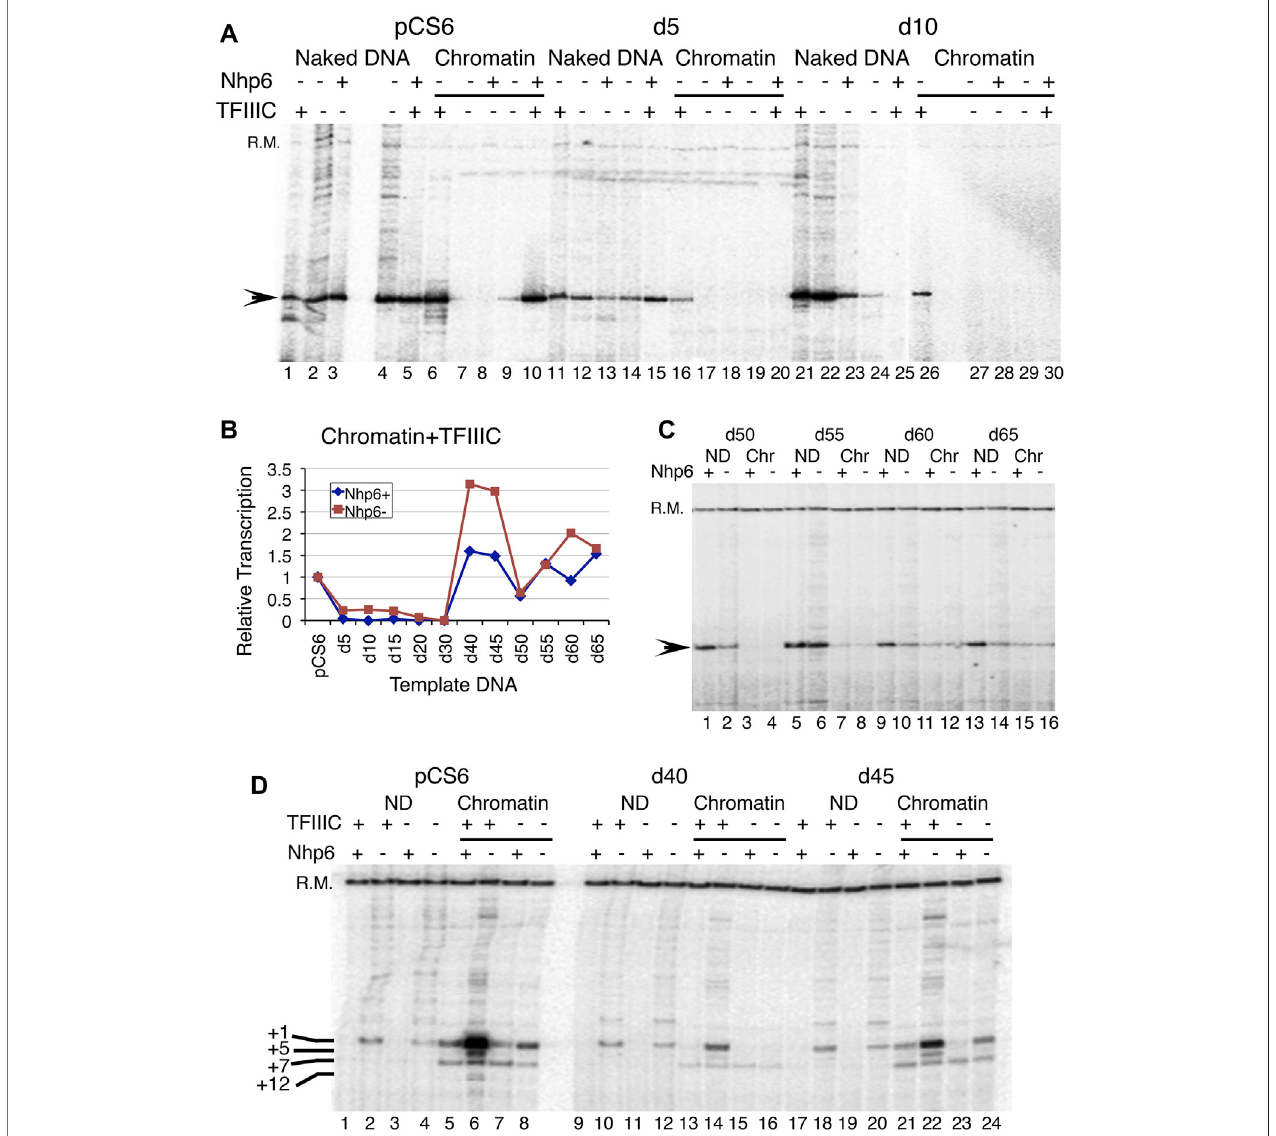
FIGURE3| Effect ofNhp6on transcription ofdeletion clones. (A) Effect ofa180-ngNhp6 addition onthetranscriptionofnakedand chromatinizedpCS6,d5, and d10 plasmids in vitro . Nhp6 supports the TFIIIC-dependent transcription of pCS6 but not of d5 and d10. (B) Quanti fi cation results of Nhp6 effect on the chromatin transcriptions of pCS6 and all deletion clones in the presence of TFIIIC with (180 ng) and without Nhp6 are plotted. Measured transcript levels were obtained by fi rst normalizingwiththe recoverymarker(R.M.) and then withthe corresponding pCS6 levels. (C) TFIIIC-dependent transcriptions ofd50-d65 ND and chromatin (Chr) are compared in the presence (108 ng) and absence of Nhp6. (D) Comparison of transcription from the ND and chromatin pCS6, d40, and d45 templates with/without TFIIICare shown. Added amount ofNhp6 was120 ng. Therecoverymarker(R.M.) and downstream-initiated transcripts from +5, +7,and +12 bp positions aremarked along with the +1 transcript on the left-hand side of the